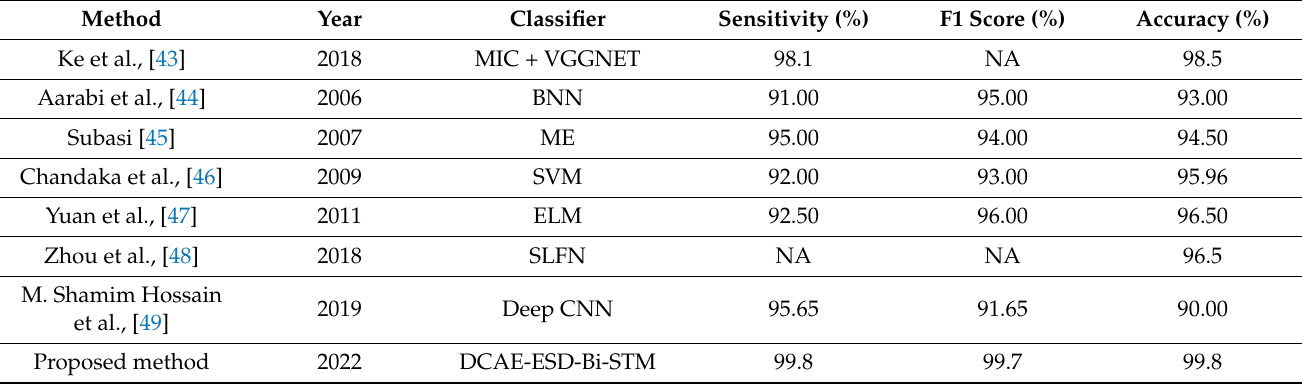
Table 3. Comparison of proposed DCAE-ESD-Bi-LSTM with other state-of-the-art